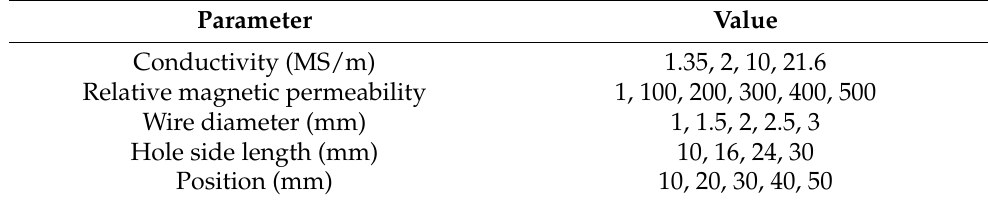
Table 1. Metal mesh